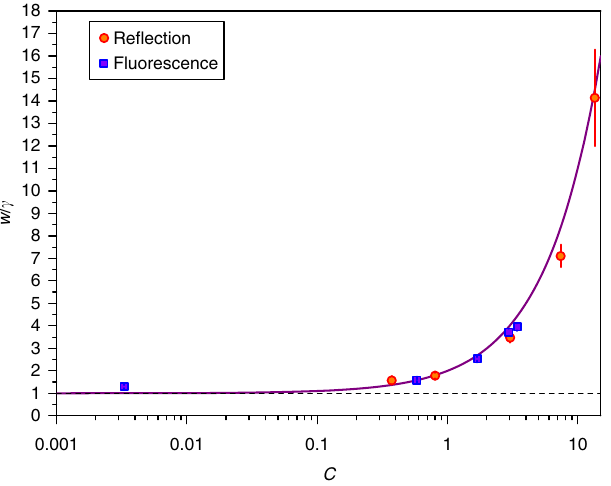
Figure 5 | Measured resonance width w versus cooperativity C . Data are extracted from the reflection and fluorescence spectra with D a ¼ D c . The Lorentzian half-widths at half-maximum are normalized to the natural atomic line width g , and error bars show the fit uncertainty. The dashed line is the asymptotic value g , while the solid line shows the prediction w ¼ g (1 þ C